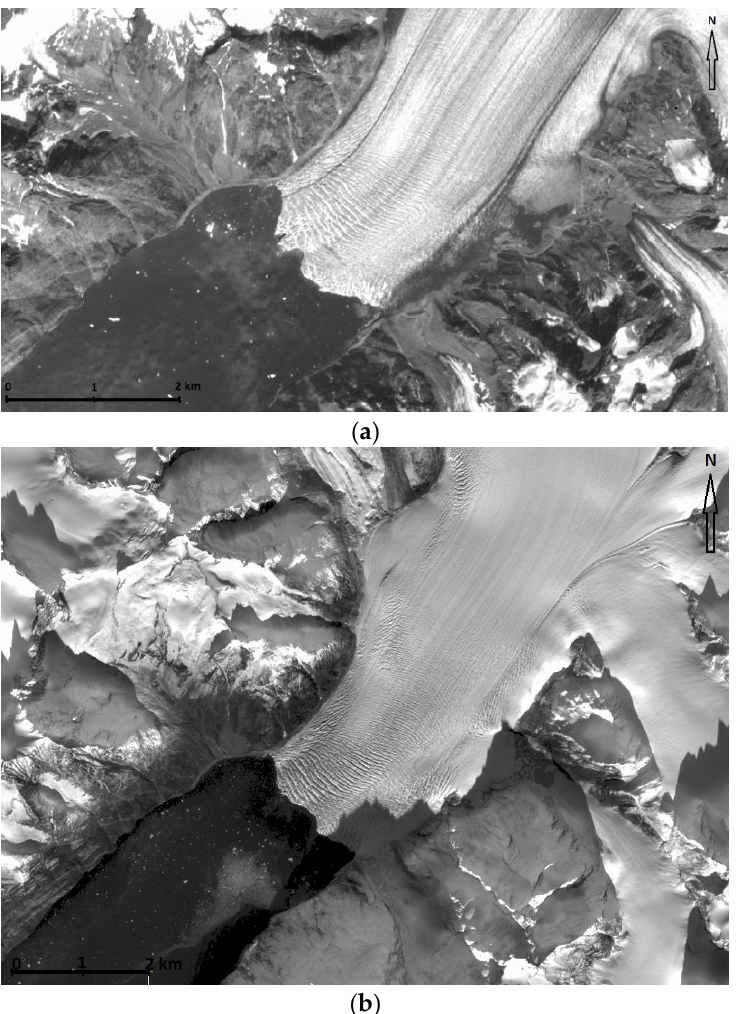
Figure 21. Sentinel 2a data; ( a ) 31 July 2020, ( b ) 9 October 2020, lower part of the glacier is affected by hill shadows.